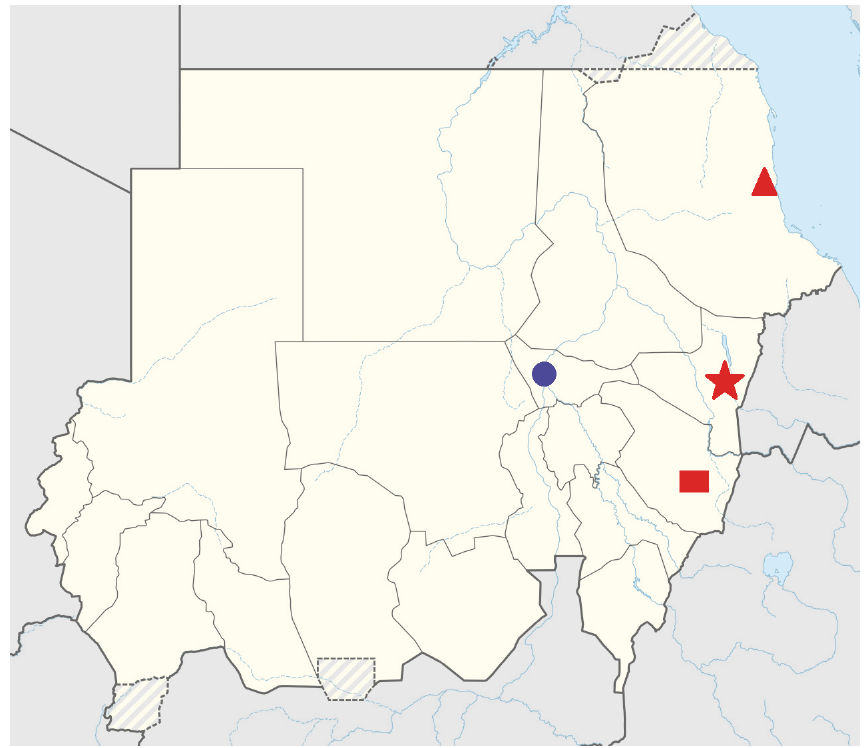
Figure 1: Map of the Sudan showing the three sampling sites. The capital city of the Sudan, Khartoum, is indicated by a blue circle and the three sampling sites are indicated by different red shapes. El-Gadarif is indicated by a square, Kassala is indicated by a star, and Port Sudan is indicated by a